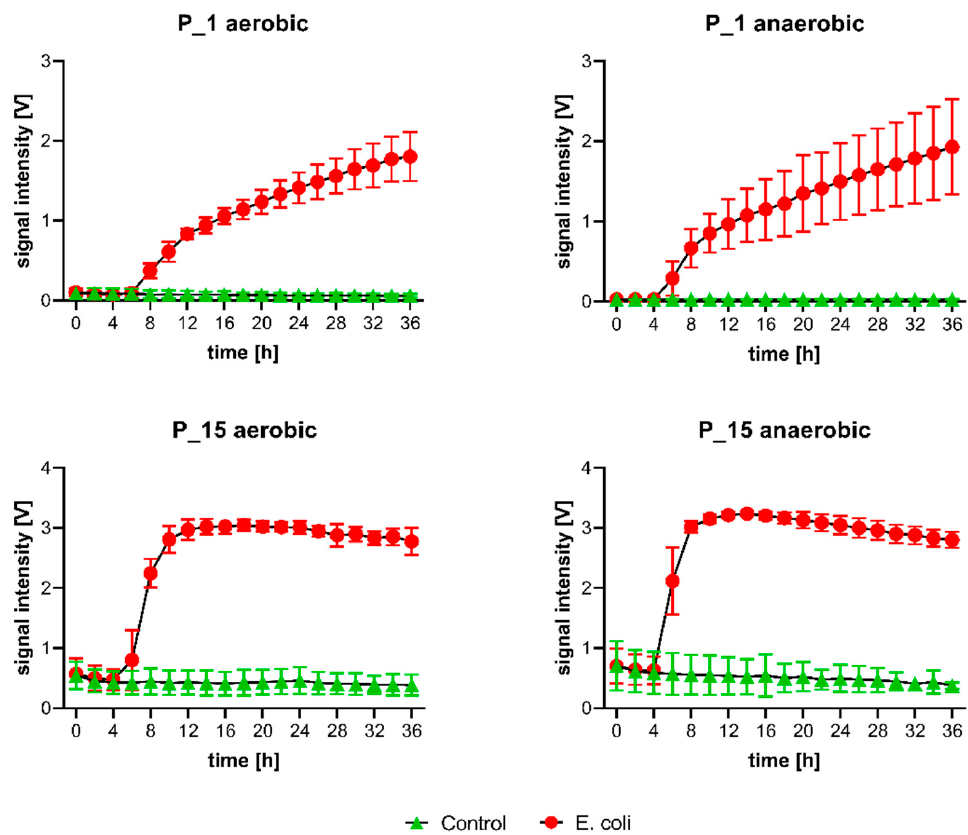
Figure 3. Development of SI (mean with corresponding 95%-CI) for control (green, n = 6) and EC group (red, n = 6) of two exemplary peaks (P_1; P_15) in aerobic ( left ) and anaerobic ( right ) media against time. An SI increase can be observed after 6–8 h.